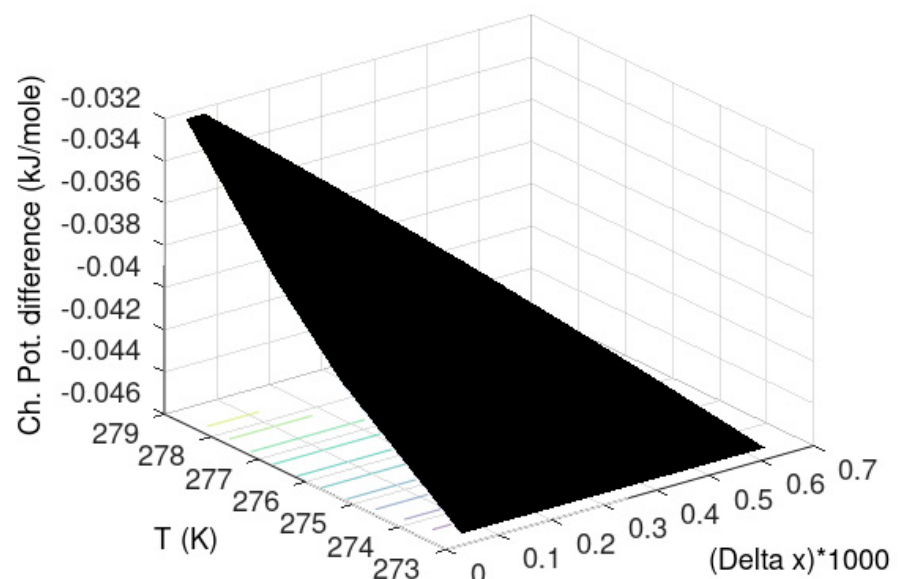
Figure 6. Super saturation for methane hydrate formed homogeneously from dissolved methane in water for conditions of temperature and pressure in Figures 4 and 5. Z -axis is chemical potential for water in hydrate minus chemical potential for liquid water, as function of temperature ( y -axis) and super saturation mole-fraction (liquid solubility mole-fraction minus hydrate stability limit mole-fraction) on the x -axis.